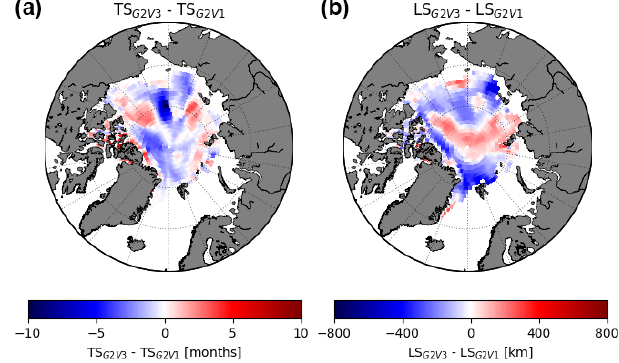
Figure 11. Grid-point differences (G2V3–G2V1) of timescale (a) and length scale (b) between two versions of the GLORYS sys- tem: G2V3 which assimilates sea ice data and G2V1 which does not assimilate sea ice